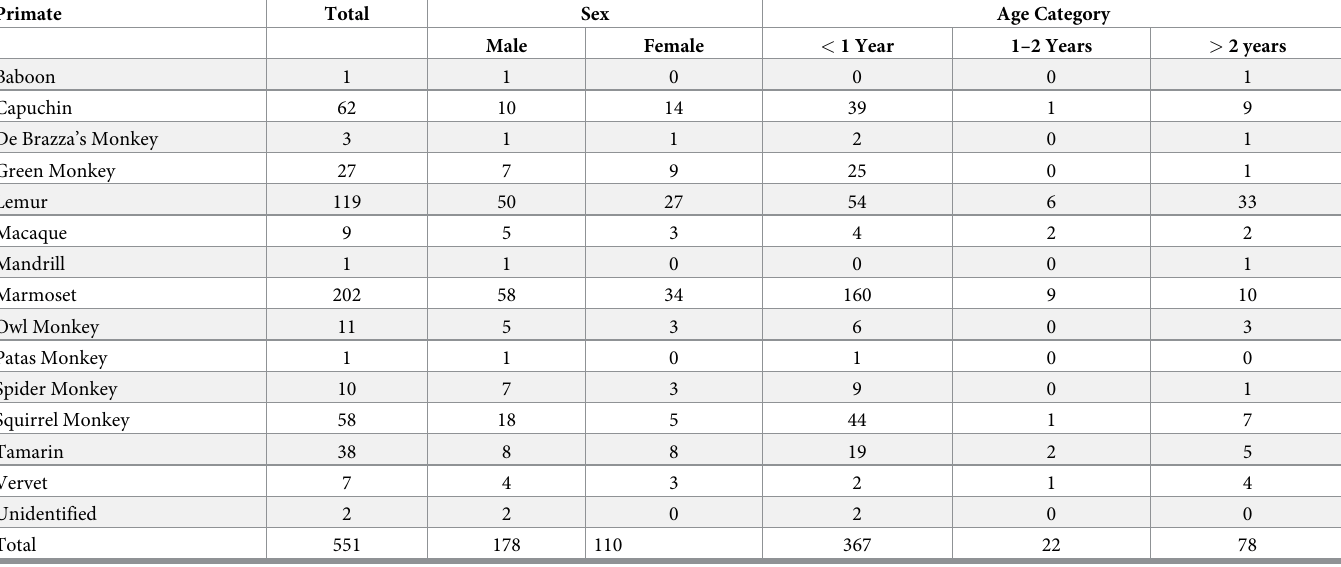
Table 1. Sampling of primates for sale in the United States. Primate